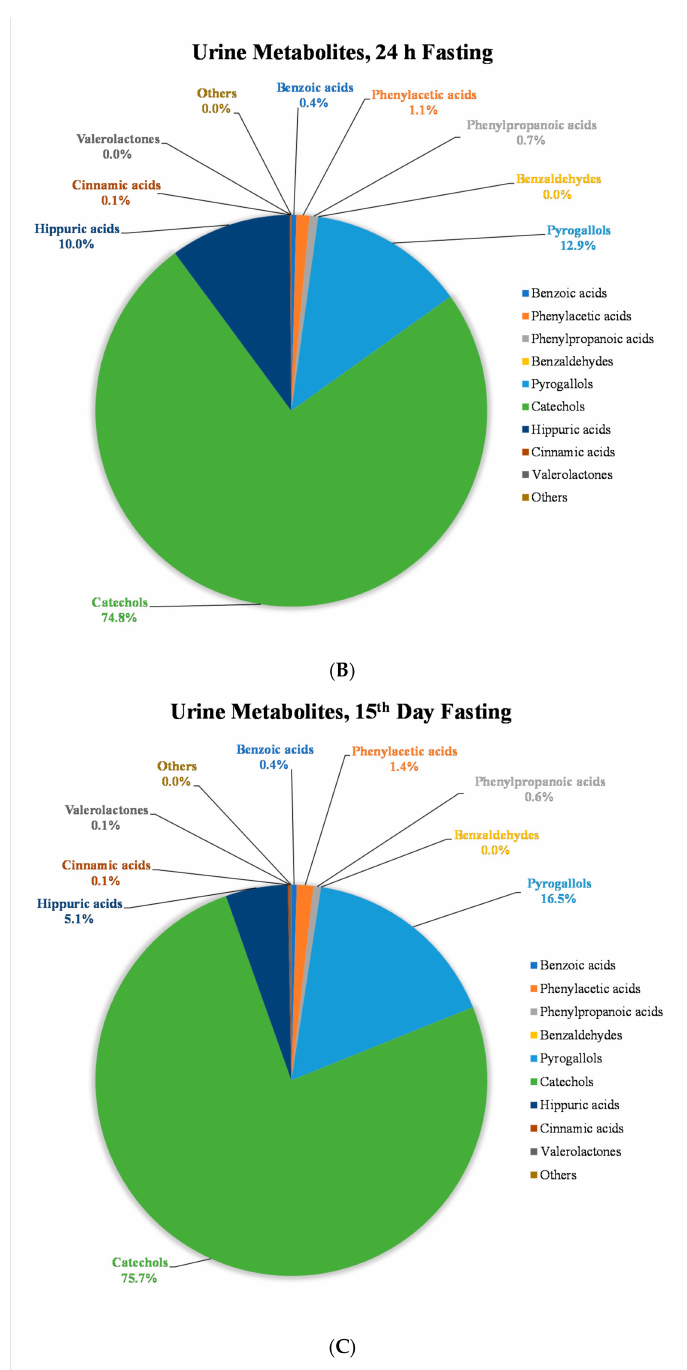
Figure 3. Distribution of concentration of (poly)phenolic metabolites classes in fasting urine at ( A ) baseline (0 h, before MP beverage intake), ( B ) 24 h fasting (24 h after single-time MP beverage intake) and ( C ) 15th day fasting (24 h after 14 days of MP beverage